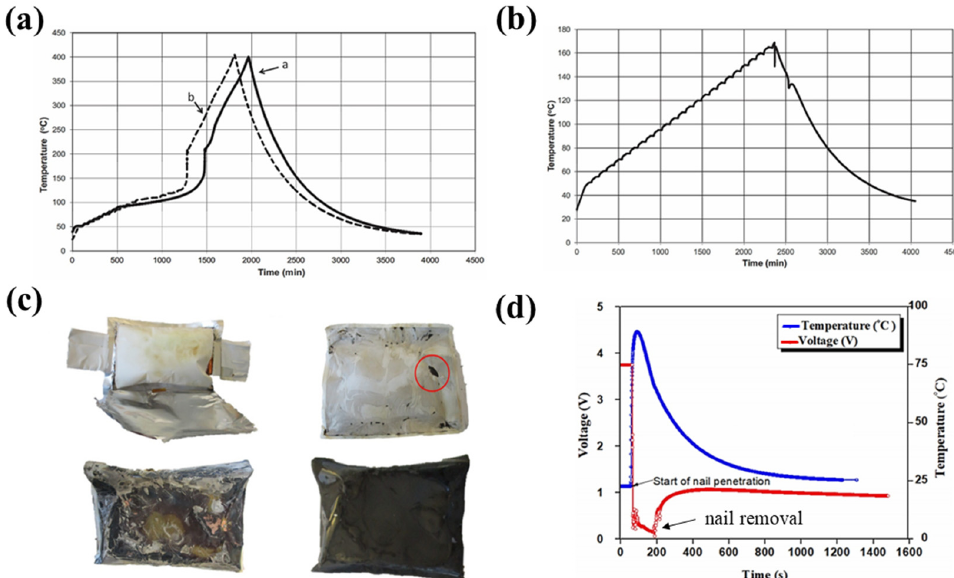
Figure 14. ( a ) The temperature vs. time curve for LIC pouch cells’ thermal characteristics where lowercase letters a and b represent two distinct types of electrolyte, ( b ) the temperature vs. time curve for EDLC (1.2 Ah) pouch cells’ thermal characteristics, reproduced with permission from [141]. Copyright 2021, Elsevier. ( c ) Inner constituents of LIC cells after the electrical abuse tests, reproduced with permission from [142], copyright 2019, Elsevier and ( d ) LIC nail-penetration test [143], open access.